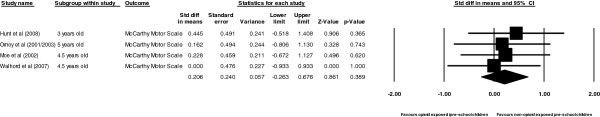
Forrest plots comparing psychomotor in opiod and non-opiod exposure.